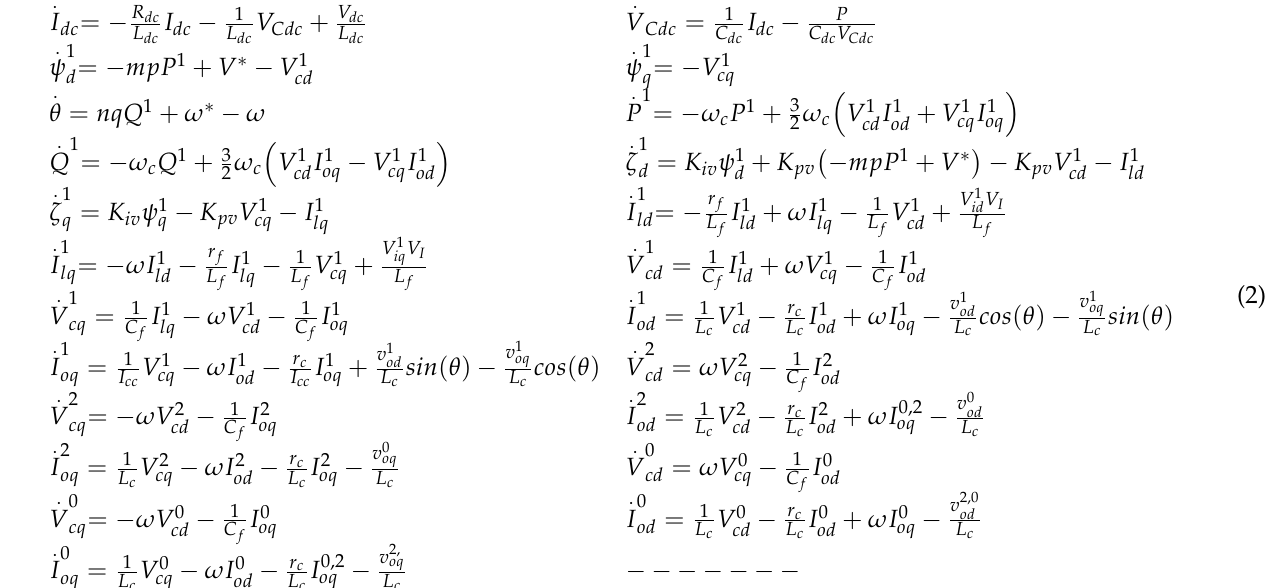
Table 1. Number and definition for each state variable.